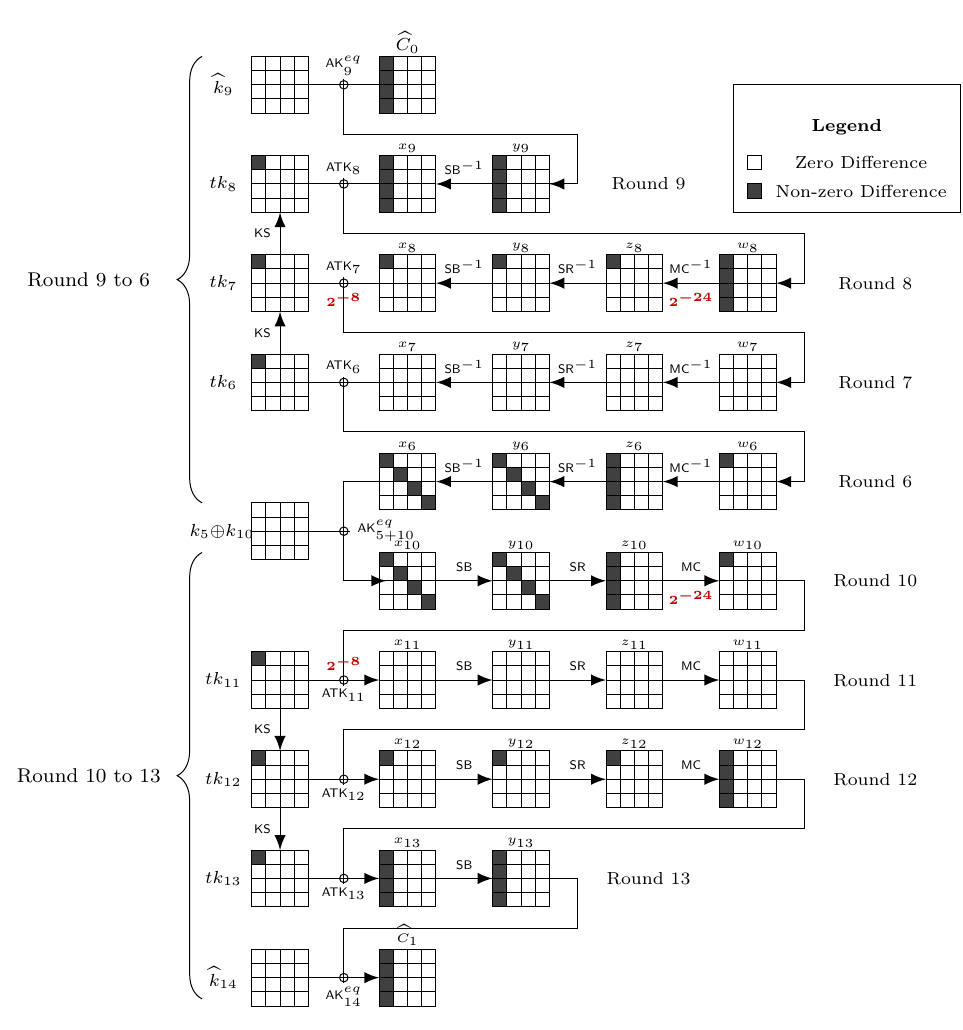
Figure 2: Truncated differential characteristic for ForkAES- ∗